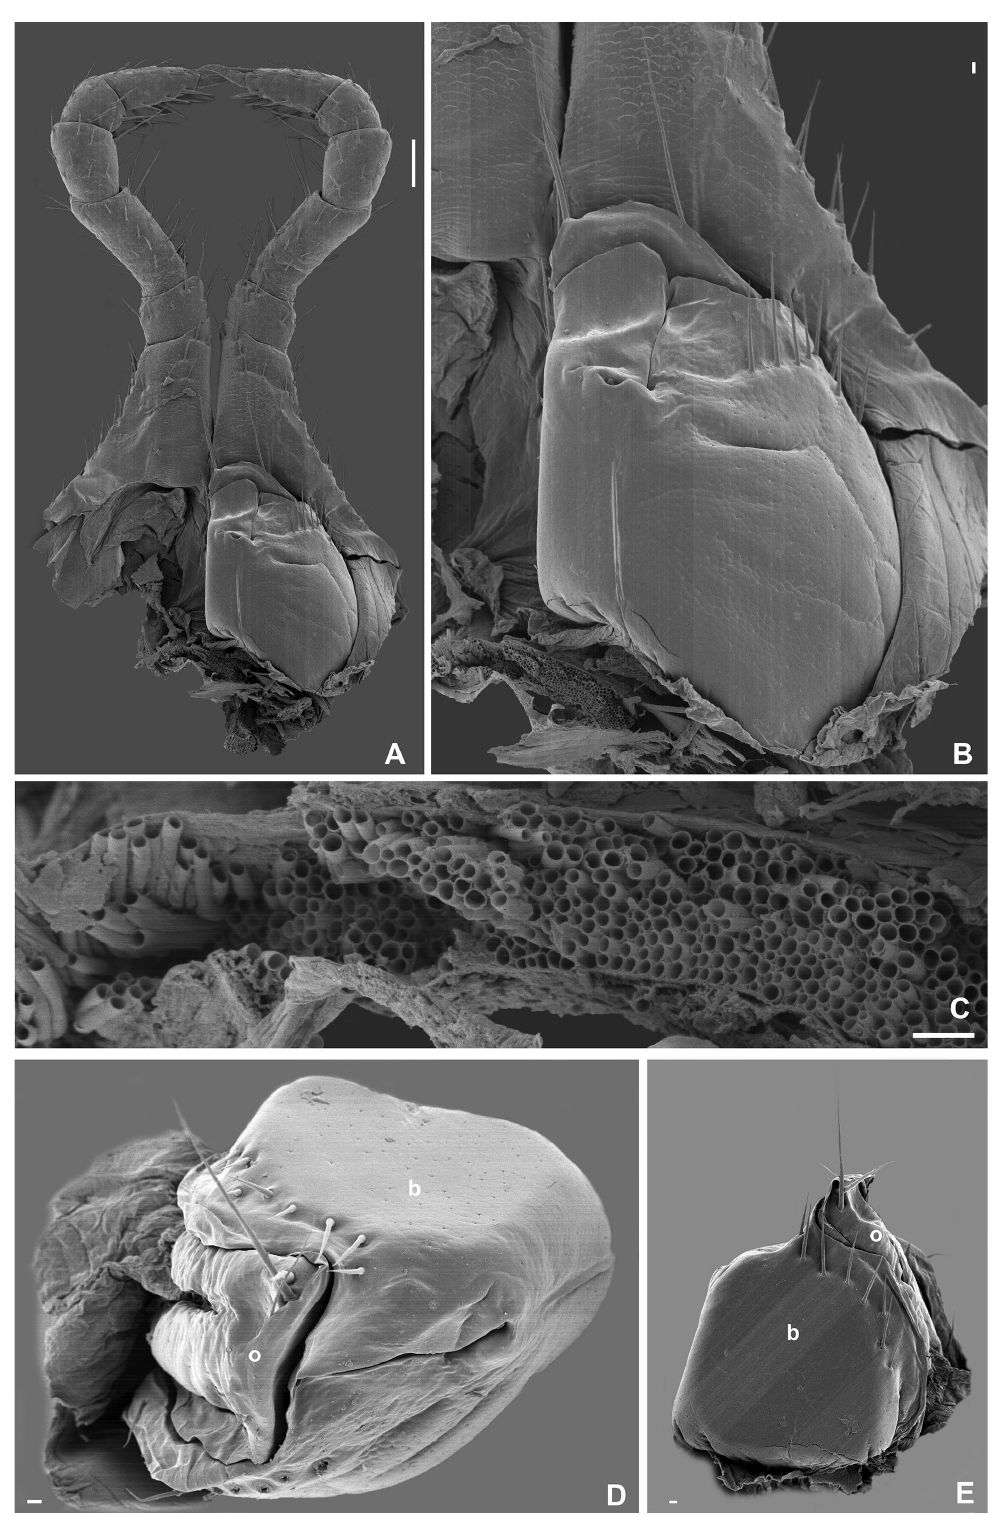
Fig. 6. Chiraziulus kaiseri (Mauriès, 1983), female vulva. Scanning electron micrographs. A . Vulva in situ behind second pair of legs, posterior view. B . Details of right vulva behind second pair of legs. C . Detail of microtubular structure under the vulva. D . Vulva in ventral view. E . Vulva in anterior view. Abbreviations: o = operculum; b = bursa. Scale bars: A = 100 μm; B–E = 10